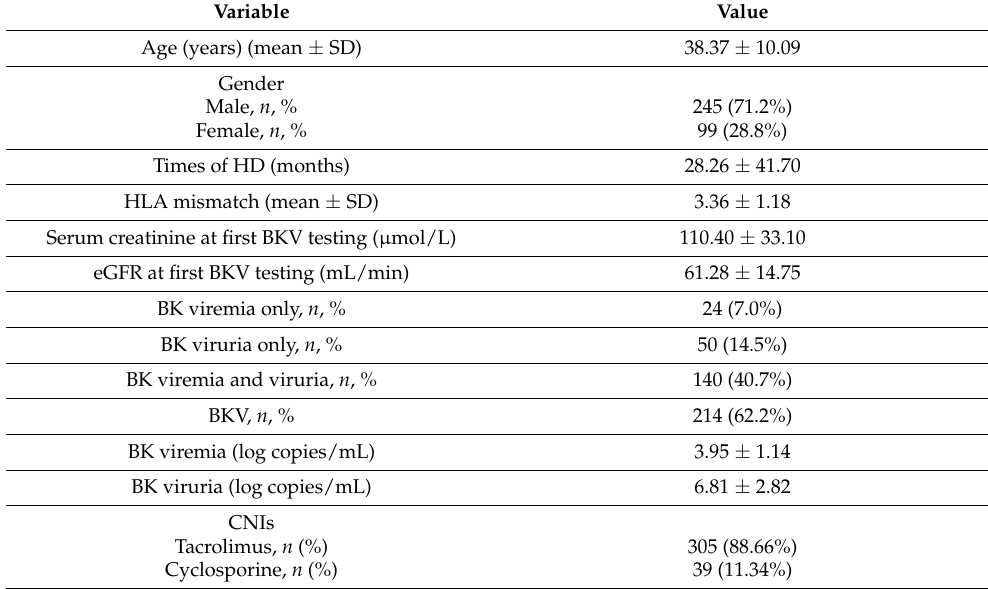
Table 3. Characteristics of kidney-transplant recipients.